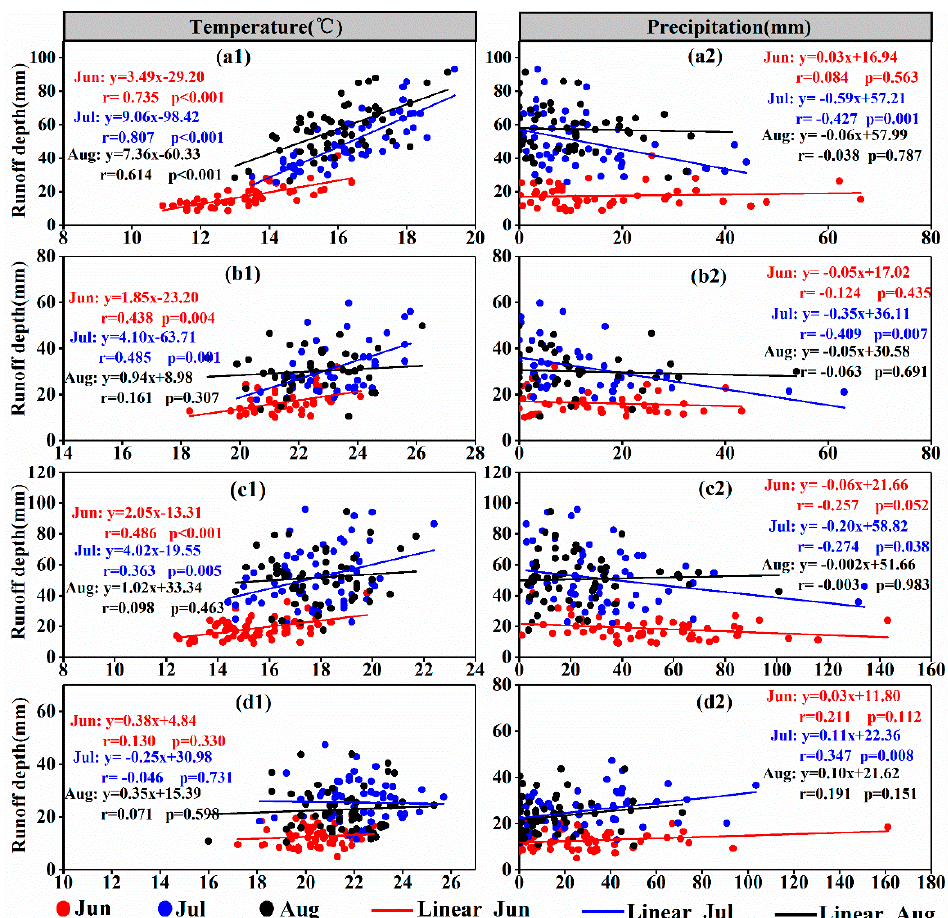
Figure 13. Regression analyses between monthly runoff and mean air temperature (left column) and precipitation (right column) of the ( a1 , a2 ) YRK, ( b1 , b2 ) KRK, ( c1 , c2 ) YUK, and ( d1 , d2 ) KRY in summer.